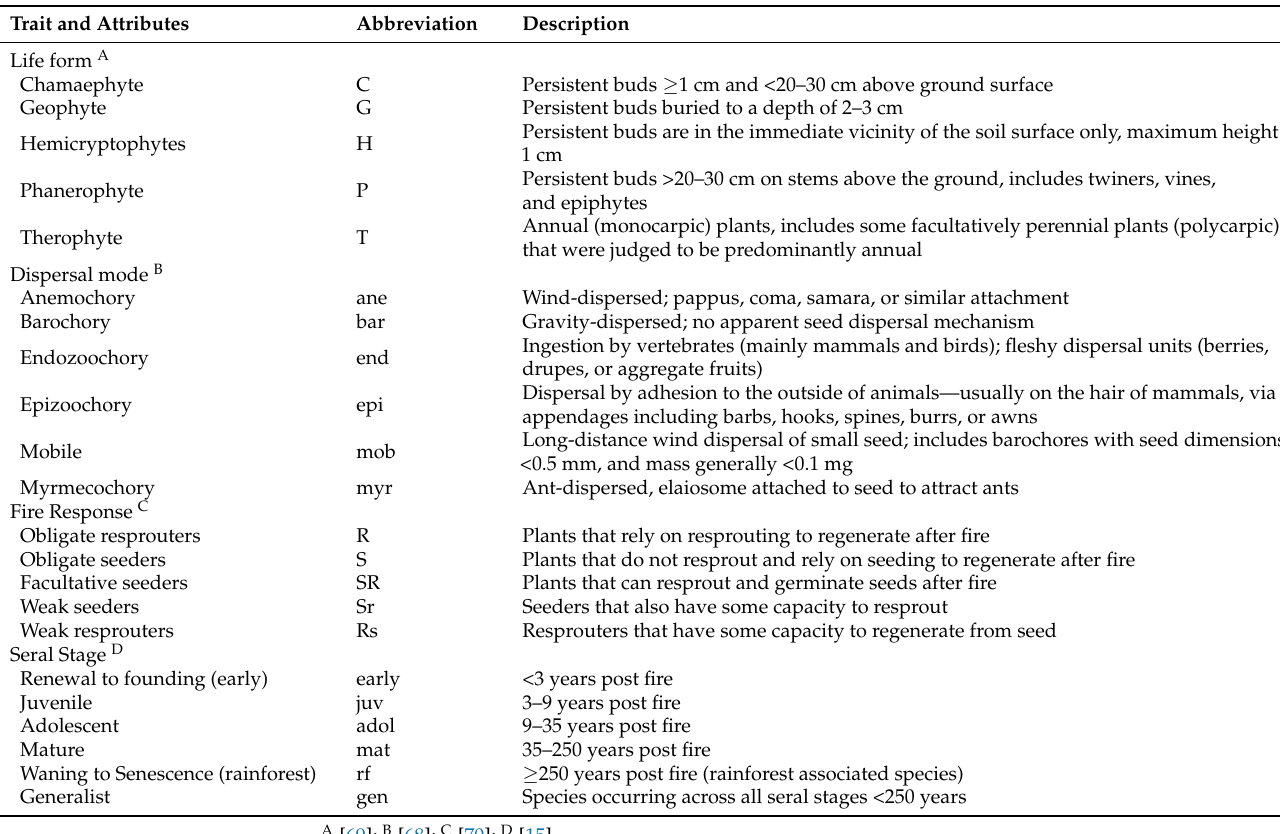
Table 2. Description of plant traits and their defining